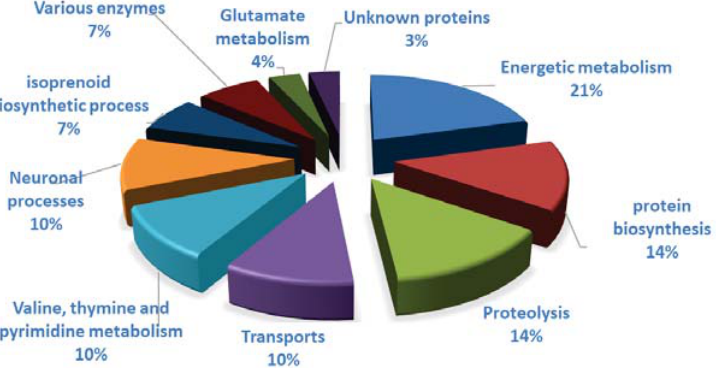
Figure 5. Functional categories of proteins displaying a change in their clothianidin/control level ratio. Proteins of control individuals with or without DMSO and clothianidin-treated individuals showing a significant variation in quantity were identified by LC-MS/MS procedures and classi- fied into 10 functional categories. The name of the protein and its reference in the online database are indicated for each identified protein.